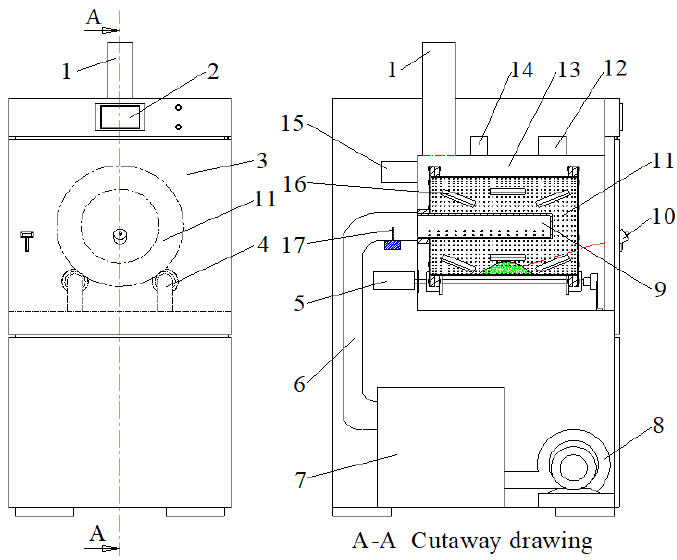
Figure 1. ORW2S-3000R microwave hot-air flow rolling dryer. 1—exhaust pipe; 2—touch screen;